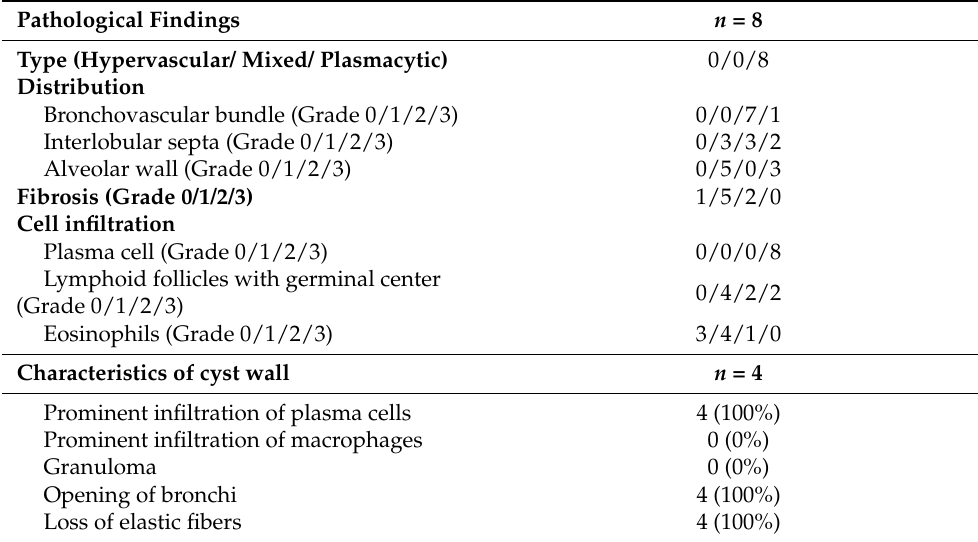
Table 4. Summary of the Pathological